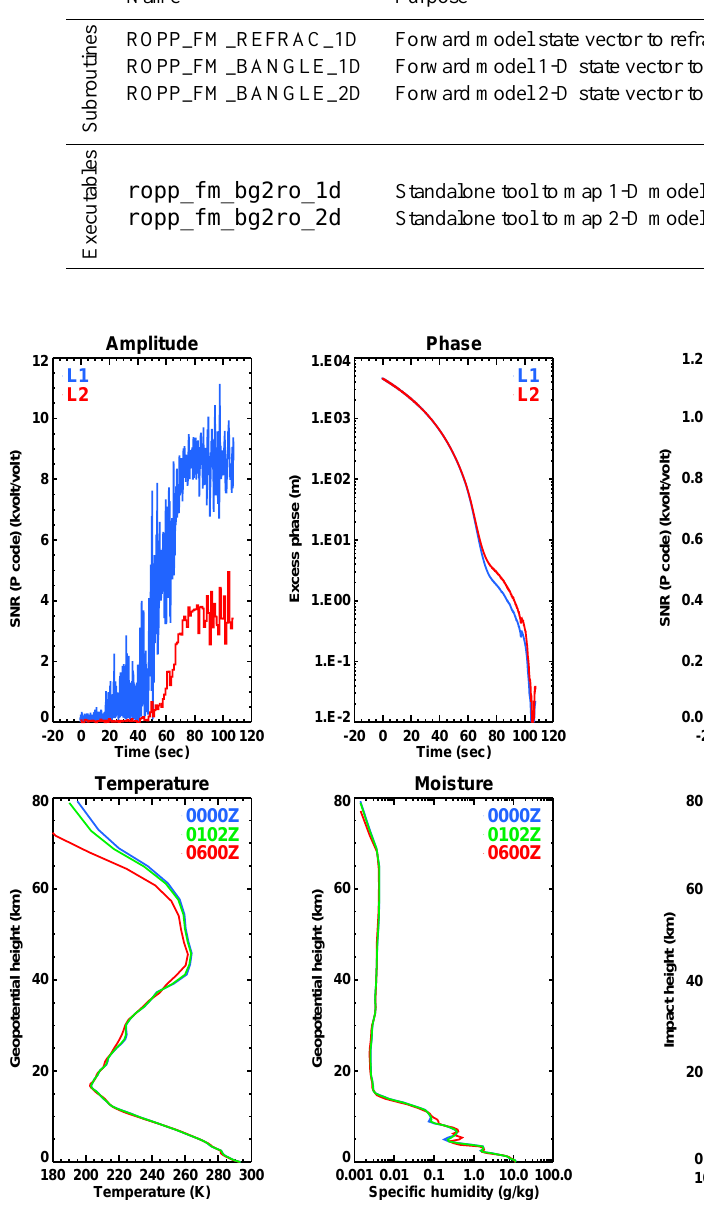
Figure 2. The results of passing “atmPhs” COSMIC data through some of the tools in the ropp_io module. Top left: L1 and L2 signal-to-noise ratios (unprocessed); top right: L1 and L2 excess phases (unprocessed); bottom left: colocated background temperatures extracted from ECMWF analysis/forecast at 00:00 and 06:00UTC, and the resulting simultaneous profile, obtained by linearly interpolating in time between them, as produced by grib2bgrasc and bgrasc2ropp ; bottom right: as bottom left but for specific humidity.